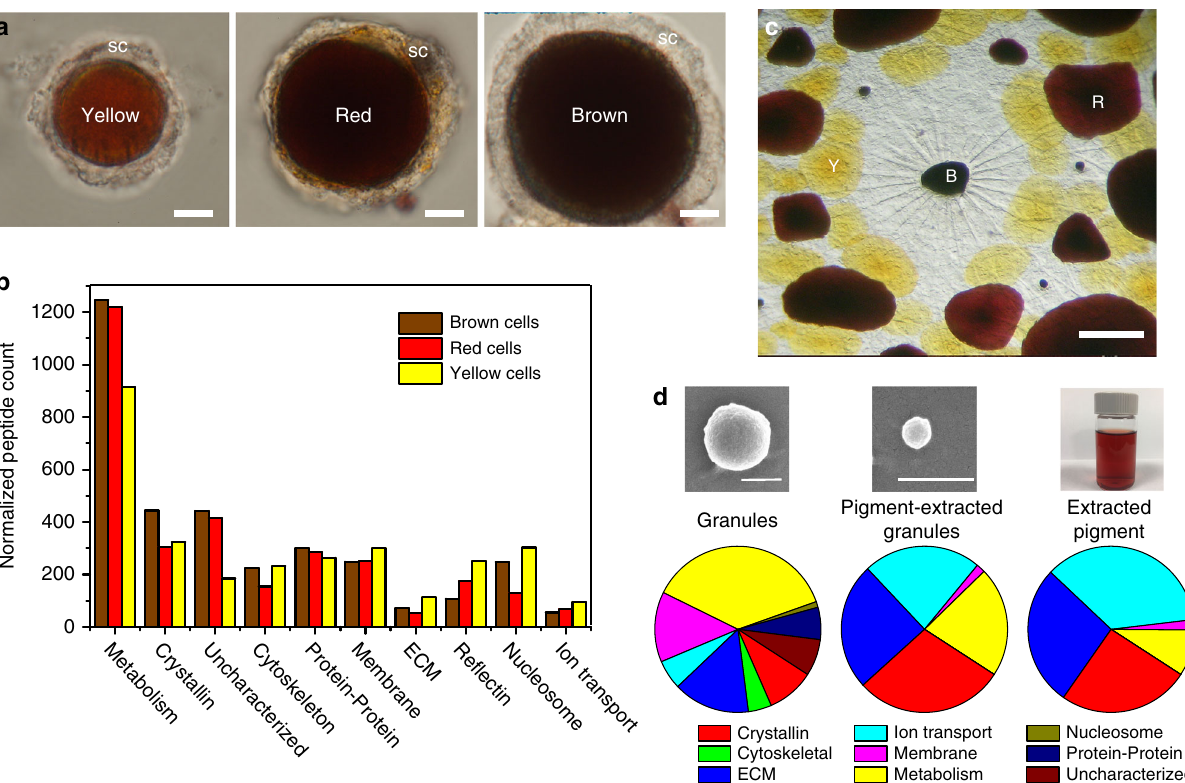
Fig. 4 Spectrometric analysis of chromatophore proteins. a Enzymatically isolated squid dorsal mantle chromatophores, retaining the plasma membrane of the variously colored chromatocytes and their surrounding sheath cells (sc). Scale bar is 6.5 µ m. b Proteins identi fi ed and categorized by function in the yellow, red, and brown pigment cells in squid D. pealeii d orsal and ventral mantle. c Typical morphological arrangement of chromatophores in squid skin; note the radial muscles visible around the central retracted brown chromatophore. Scale bar is 500 µ m. d Categorized proteins identi fi ed within the squid chromatophore granules, pigment-extracted granules (e.g., the granule shell), and the extracted pigment along with representative SEMs (scale bar = 500 nm) and optical image of extracted